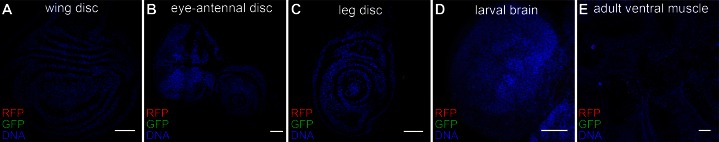
GFP, RFP and DAPI fluorescence in imaginal discs from flies carrying CasExpress, Gal80ts, and G-TRACE raised at 18°C.GFP and RFP are completely repressed.